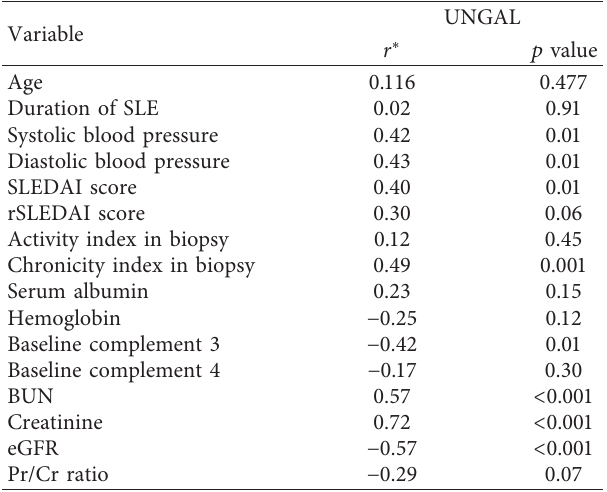
Table 2: Correlation of baseline UNGAL with demographic, clinical, and laboratory data of